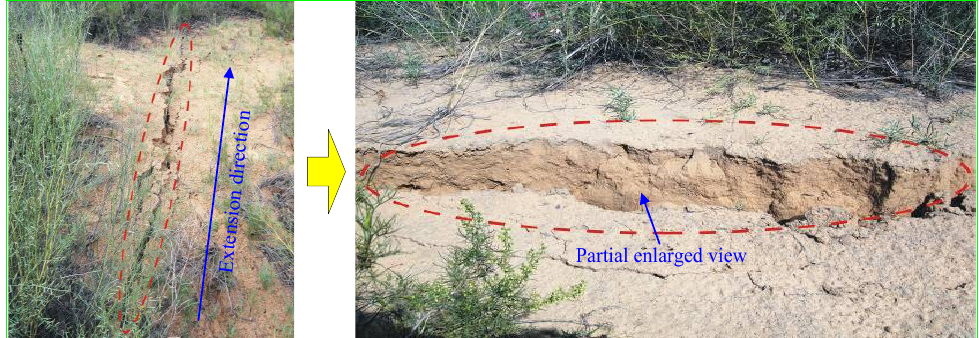
Figure 15. Through cracks on the surface during the first